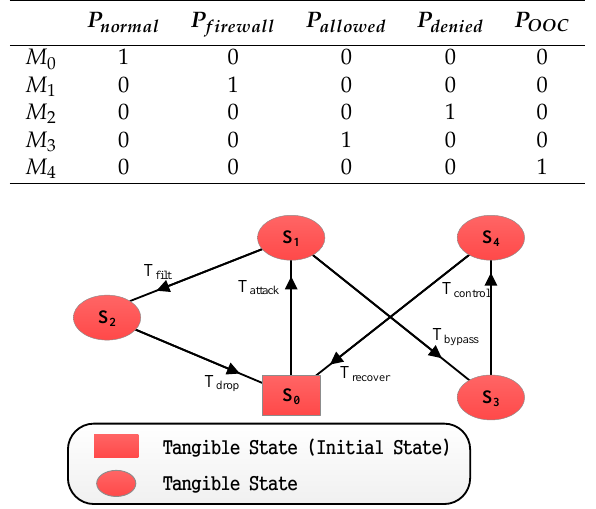
Table 7. Reachable markings’ set of Scenario I.